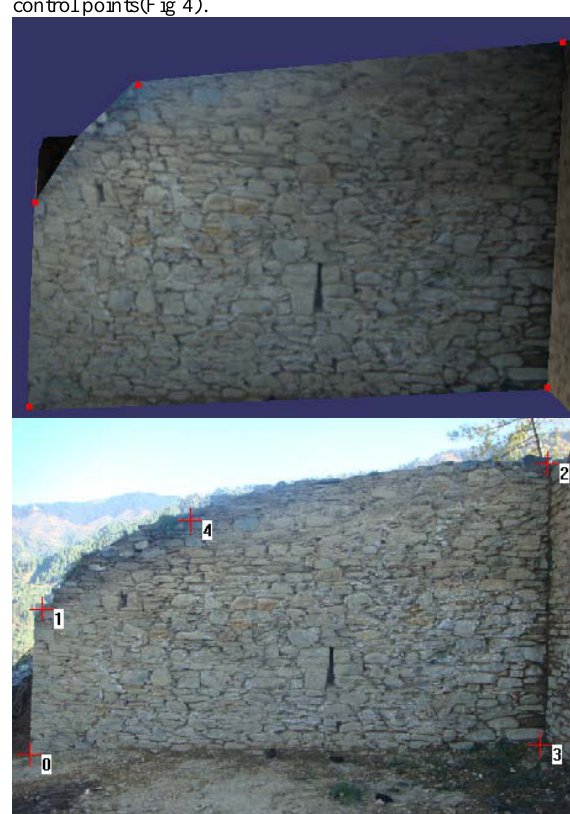
Figure 4: control points based texture mapping.